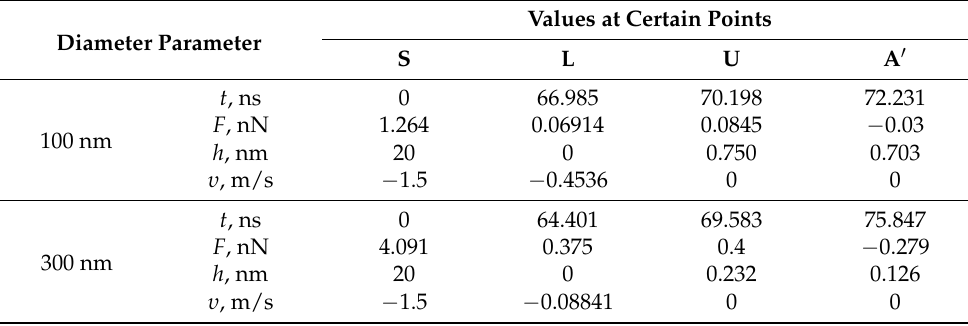
Table 2. Particle interaction properties during interaction at certain points S-L-U-A (cid:48) . Diameter